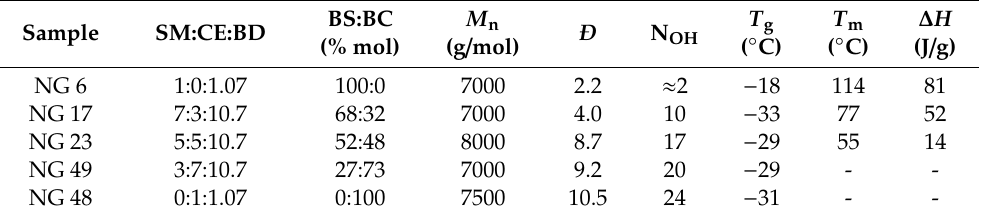
Table 1. Properties of synthesized poly(butylene succinate), poly(butylene succinate– co –butylene citrate) and poly(butylene